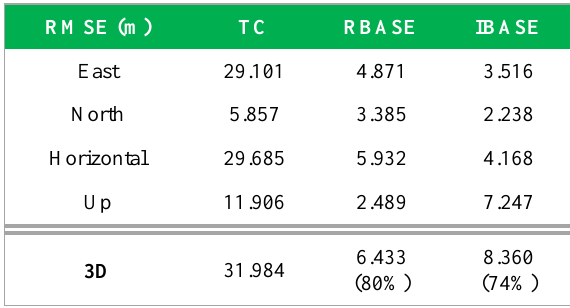
Table 3. RMSE of TC RBASE and IBASE